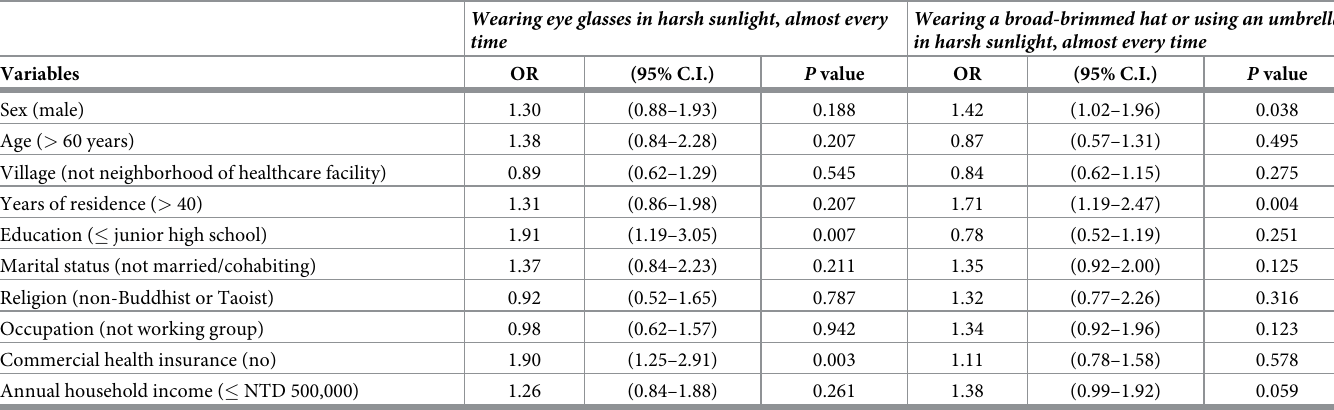
Table 5. Relationship between socio-demographic characteristics and practices of eye protection under sun exposure.